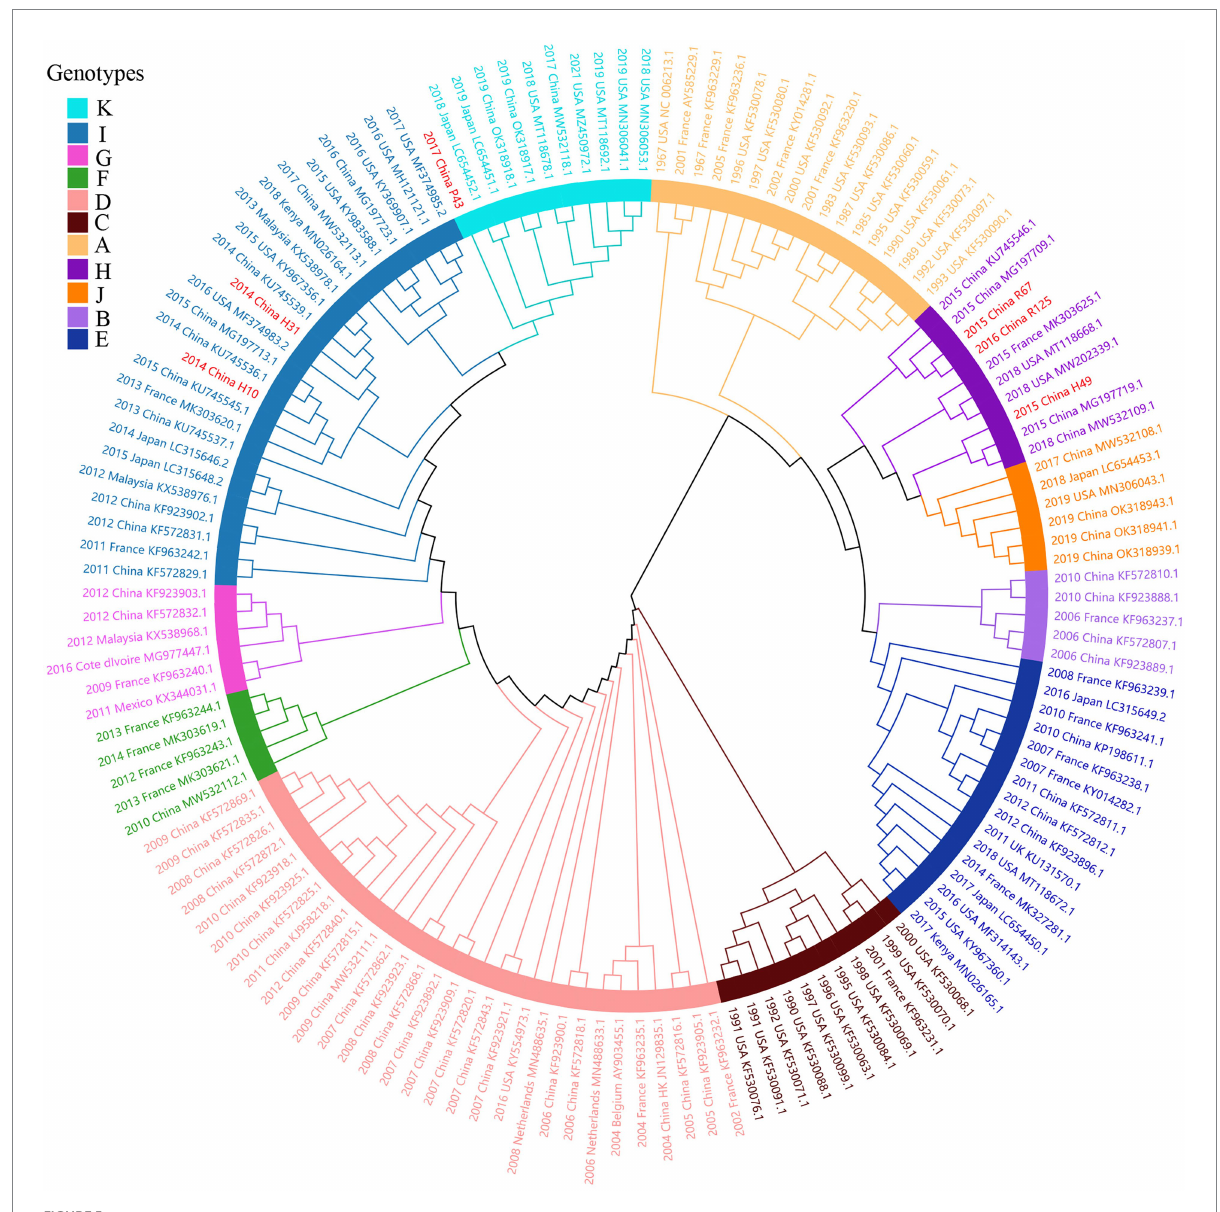
FIGURE 5 ML tree for the complete S gene of HCoV-OC43. Different genotypes are distinguished by different colors and sequences obtained in this study are colored red. The year of sampling, city and accession number are at the tip labels. Phylogenetic analysis using MEGA v6.0 with 1,000 bootstrap